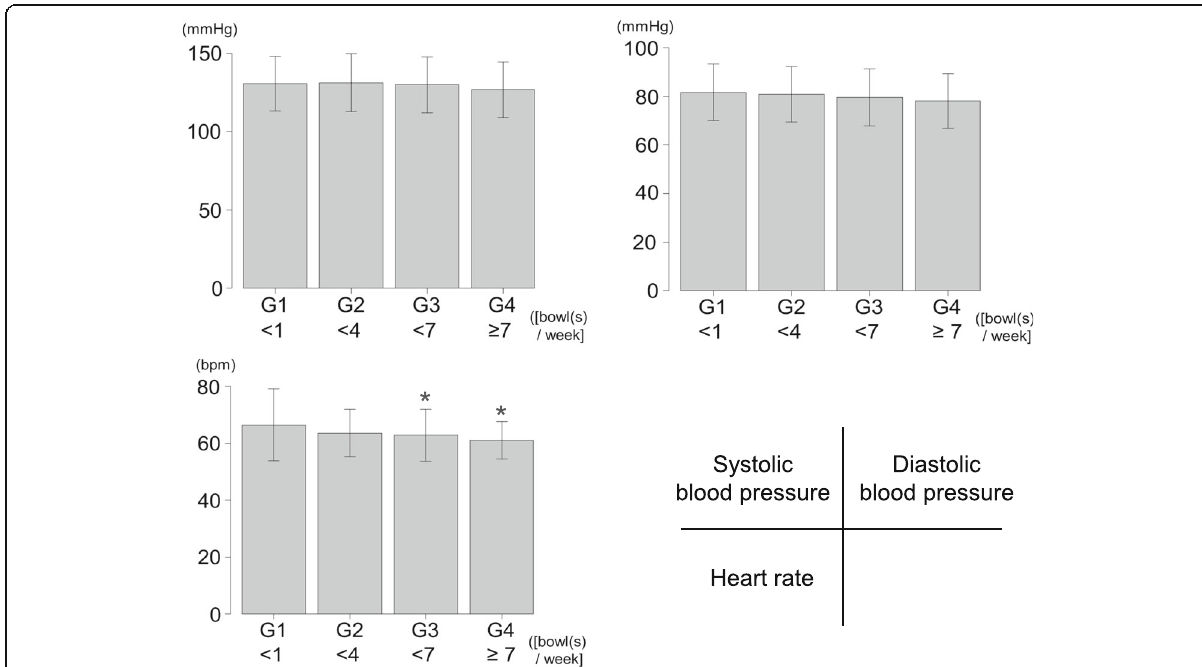
Fig. 3 Blood pressure levels and heart rates in each group. G1, Group 1 (< 1 bowl of miso soup/week); G2, Group 2 (< 4 bowls of miso soup/ week); G3, Group 3 (< 7 bowls of miso soup/week); G4, Group 4 ( ≥ 7 bowls of miso soup/week). * p < 0.05 versus